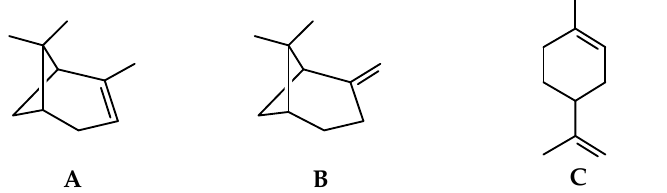
Figure 2. Main volatile compounds found in the fruits of all cultivars of black pepper. ( A ) α -pinene; ( B ) β -pinene; ( C )